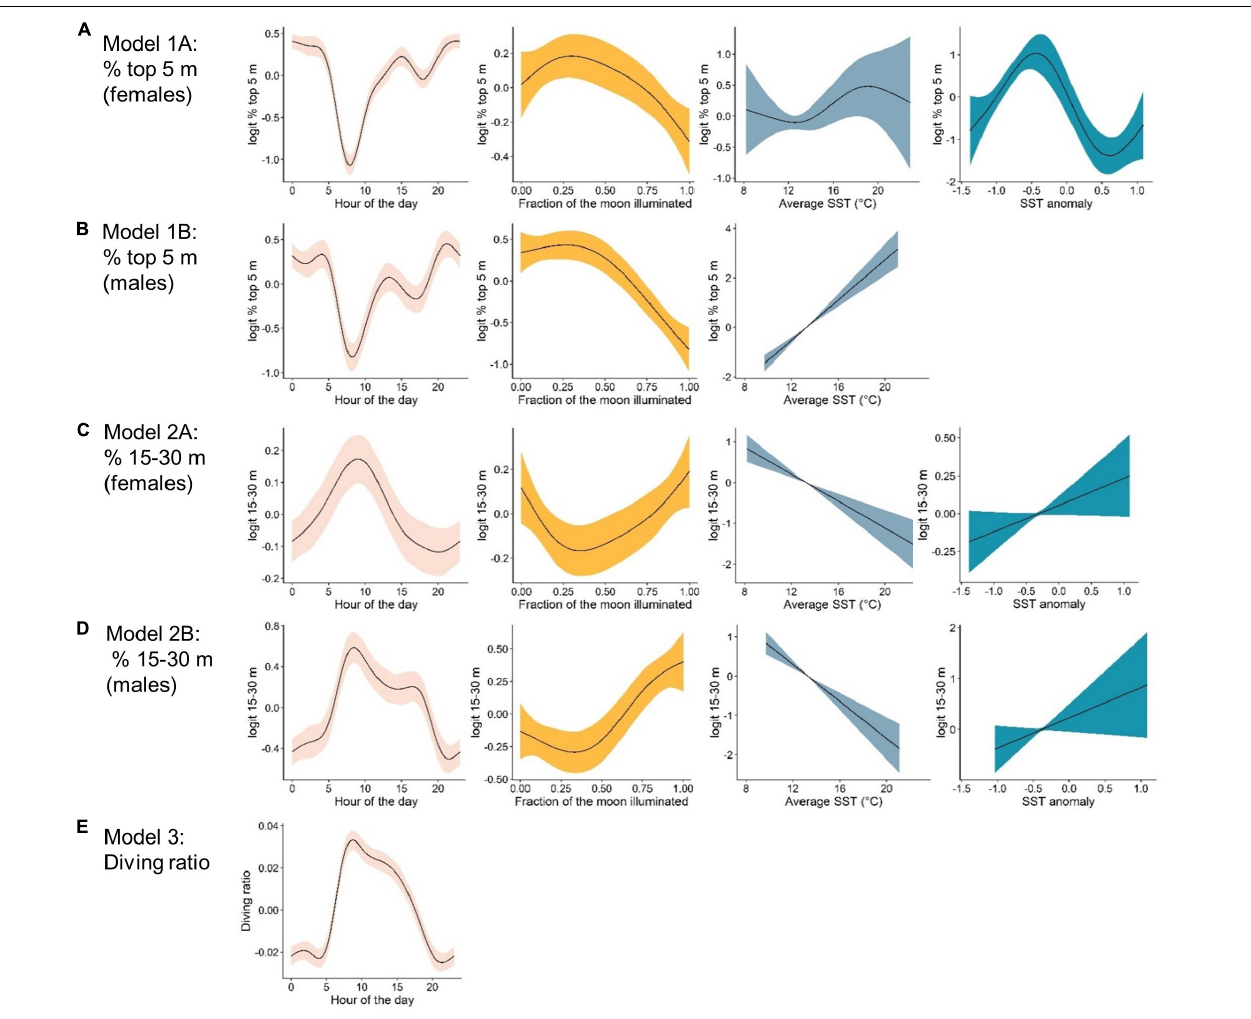
FIGURE 4 | Marginal effects plots from top-ranked generalized additive mixed models indicating the effects, from left to right, of: hour of the day, lunar illumination, average sea surface temperature ◦ C (SST) and SST anomaly, on vertical movement metrics. The response variable for each model are as follows: (A) % time in the top 5 m by females. (B) % time in the top 5 m by males. (C) % time in the 15–30 m depth bin by females. (D) % time in the 15–30 m depth bin by males, and (E) the diving ratio. Note that scales on the y -axes differ between plots.